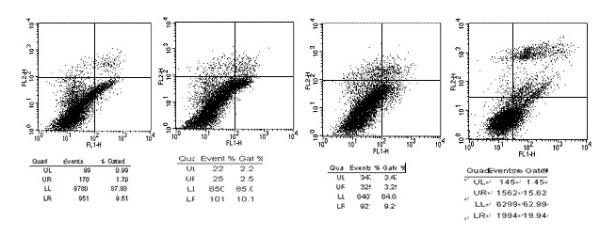
Transfection of Ad-CALR/MAGE-A3 induced apoptosis of glioblastoma cells. The transfected cells, labeled with AnnexinV-FITC and PI, were subjected to floe cytometric analysis. Two parameter histogram Dot Plot displayed FL1-FITC on the x axis and FL2-PI on the y axis. The result showed that Ad-CALR/MAGE-A3 increased the apoptotic rate in U87 cells.